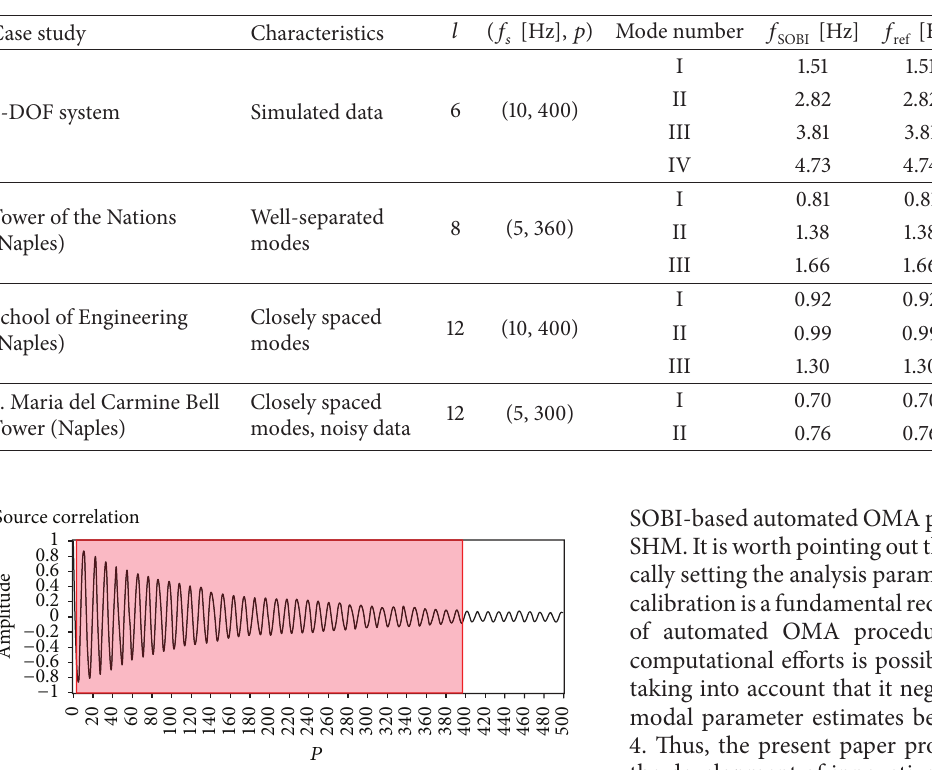
Figure 3: Sensitivity of overall accuracy (a) and mode shape accuracy (b) to 𝑝 and 𝑡 . Table 2: Test cases, modal identification results, and comparisons.